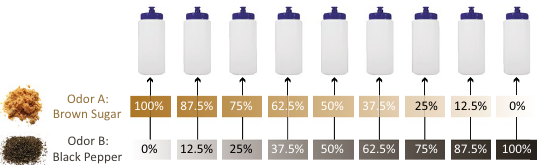
Figure 1. Parametrically varied odor stimuli. We prepared nine opaque bottles containing mixtures of brown sugar (Odor A ) and black pepper (Odor B ). Two additional bottles served as standards, one containing only brown sugar and the other containing only black pepper. Standard bottles were labeled A and B , respectively, and participants were allowed to reference these bottles throughout the experiment to aid in their judgments. The nine unlabeled stimulus bottles contained combinations of brown sugar and black pepper in varying proportions. The weights of the bottles were equated, and the overall quantities of brown sugar and black pepper were chosen to roughly equate the perceived intensity of the two when each was smelled in isolation (see in "Methods"